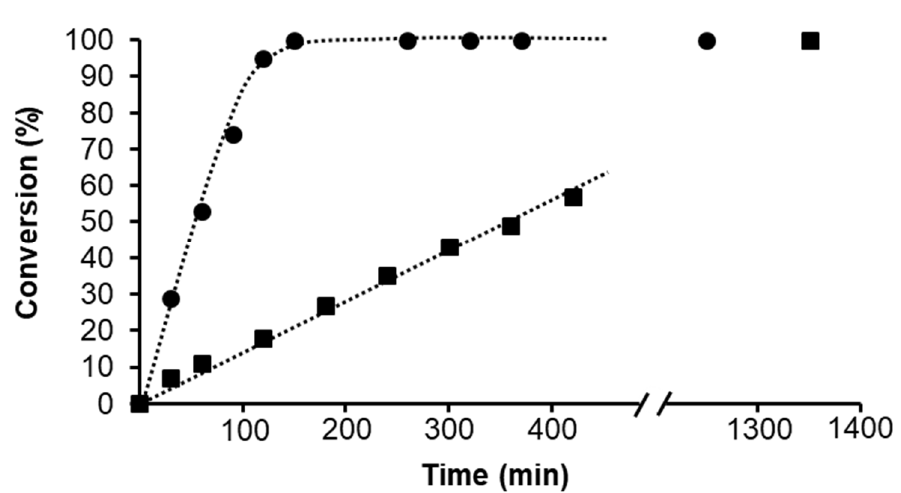
Figure 2. Time course of phenylacetylene hydrogenation in MeOH solution catalyzed by [RuHCl(CO)( m tppms ‐ Na) 3 ], 1 ( ● ) and [RuH(H 2 O)(CO)( m tppms ‐ Na) 3 ][BF 4 ], 2 [BF 4 ] ( ■ ) Conditions: [phenylacetylene] = 6.25×10 − 2 M, [Ru] = 1.25×10 − 3 M, P (H 2 )= 1 bar, T = 60 °C. Analysis of the reaction mixture by gas